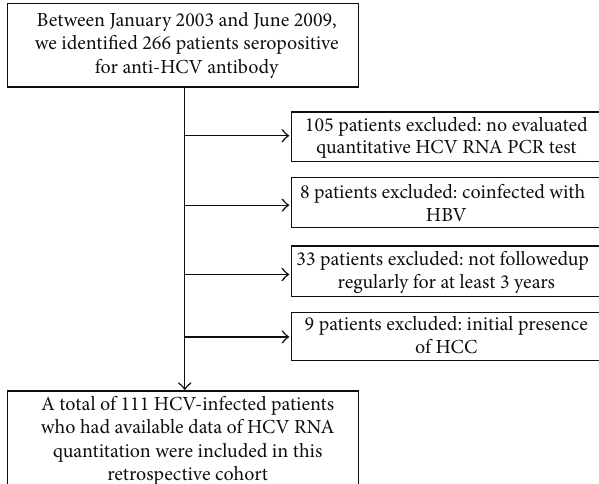
Figure 1: Schematic flow of the recruitment of study participants.